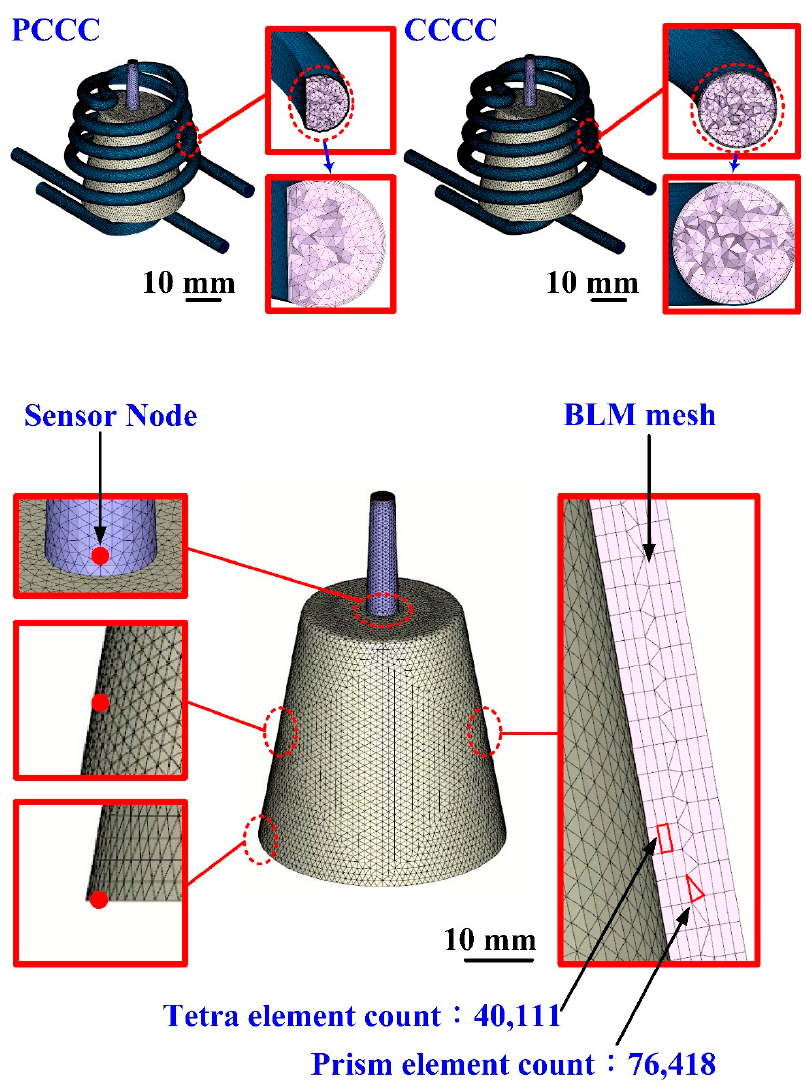
Figure 11. Mesh of the injection-molded part and cooling channels.